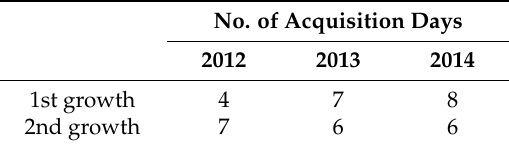
Table 1. Number of data acquisition days between 2012 and 2014.